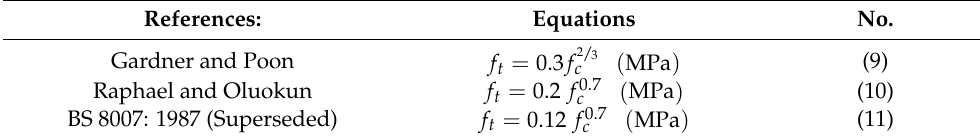
Table 3. Relationship between compressive and direct tensile strengths Neville, 2011 [43].